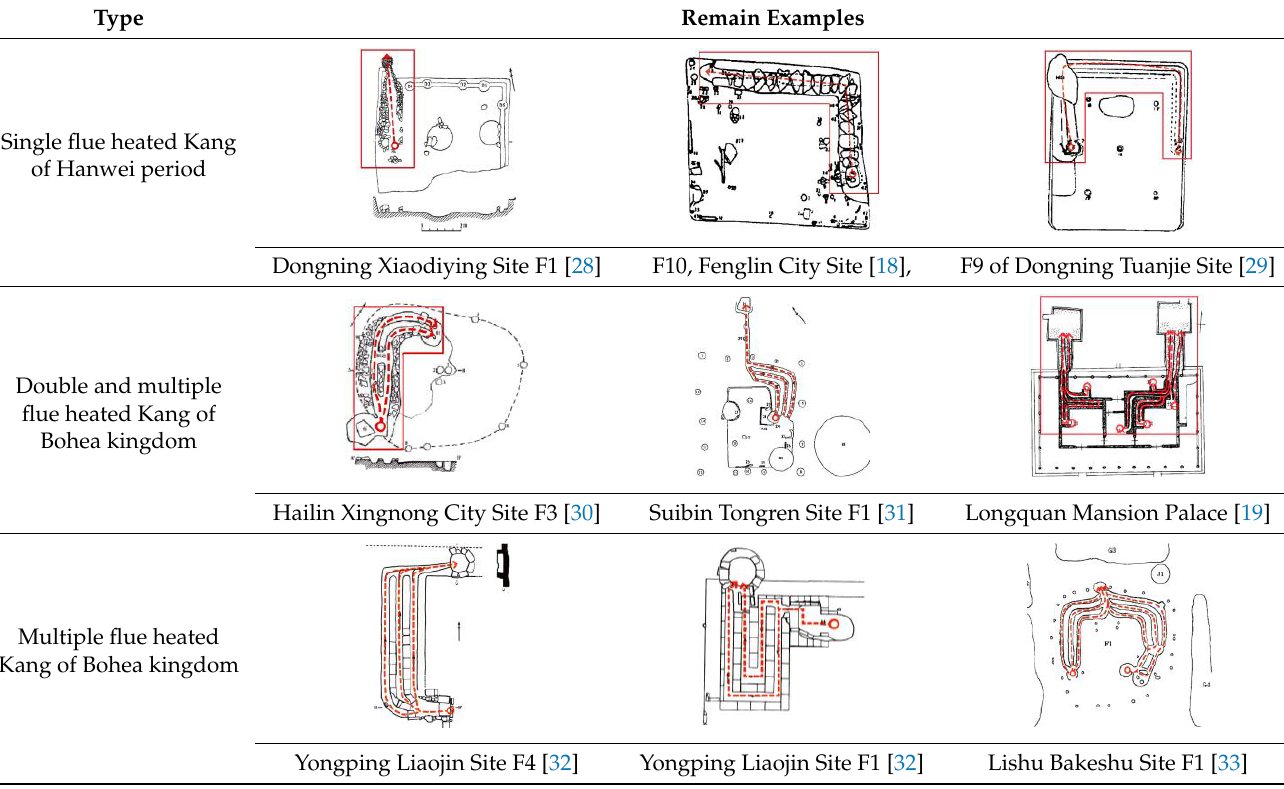
Table 7. Case site plan and model diagram [18 – 20].